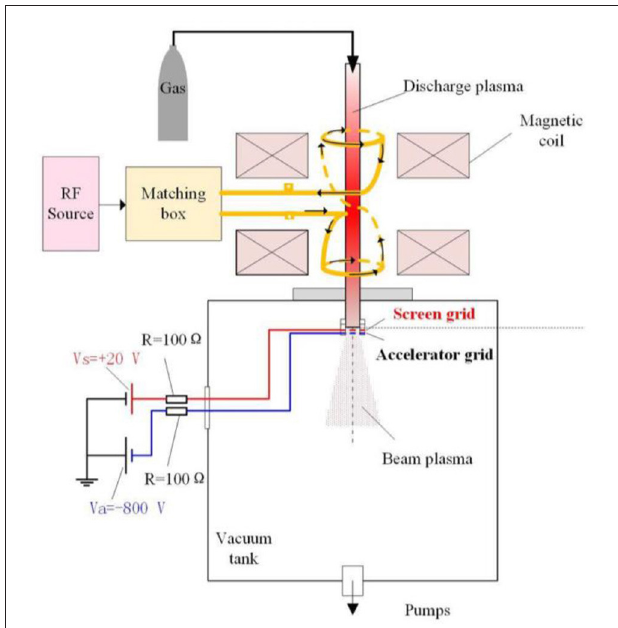
FIGURE 11 | Helicon ion thruster system diagram.